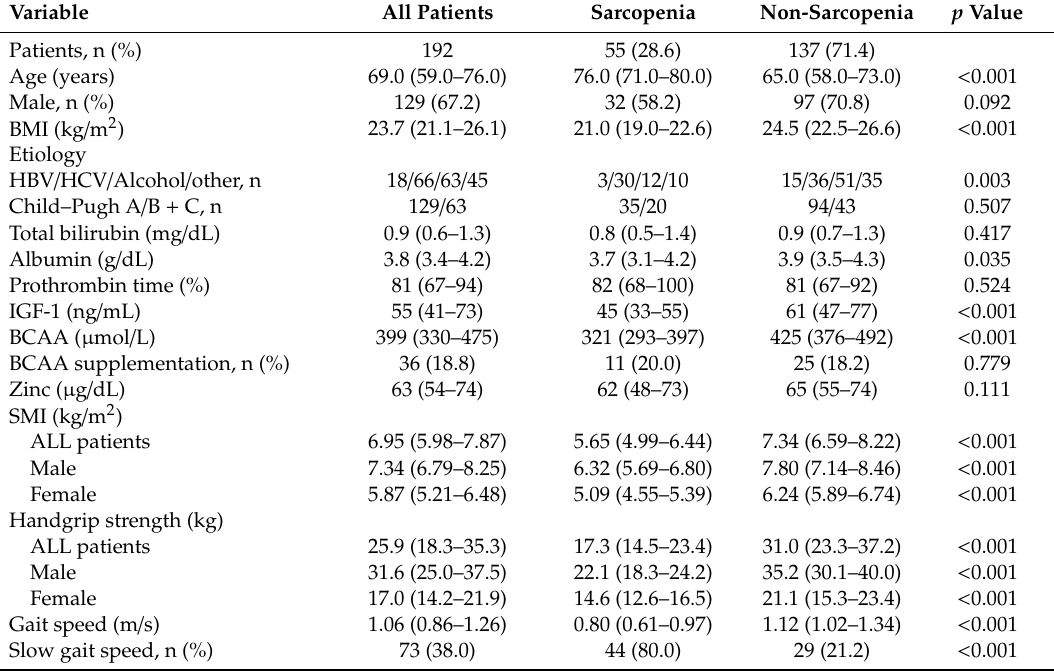
Table 1. Comparison of clinical characteristics between patients with and without sarcopenia.